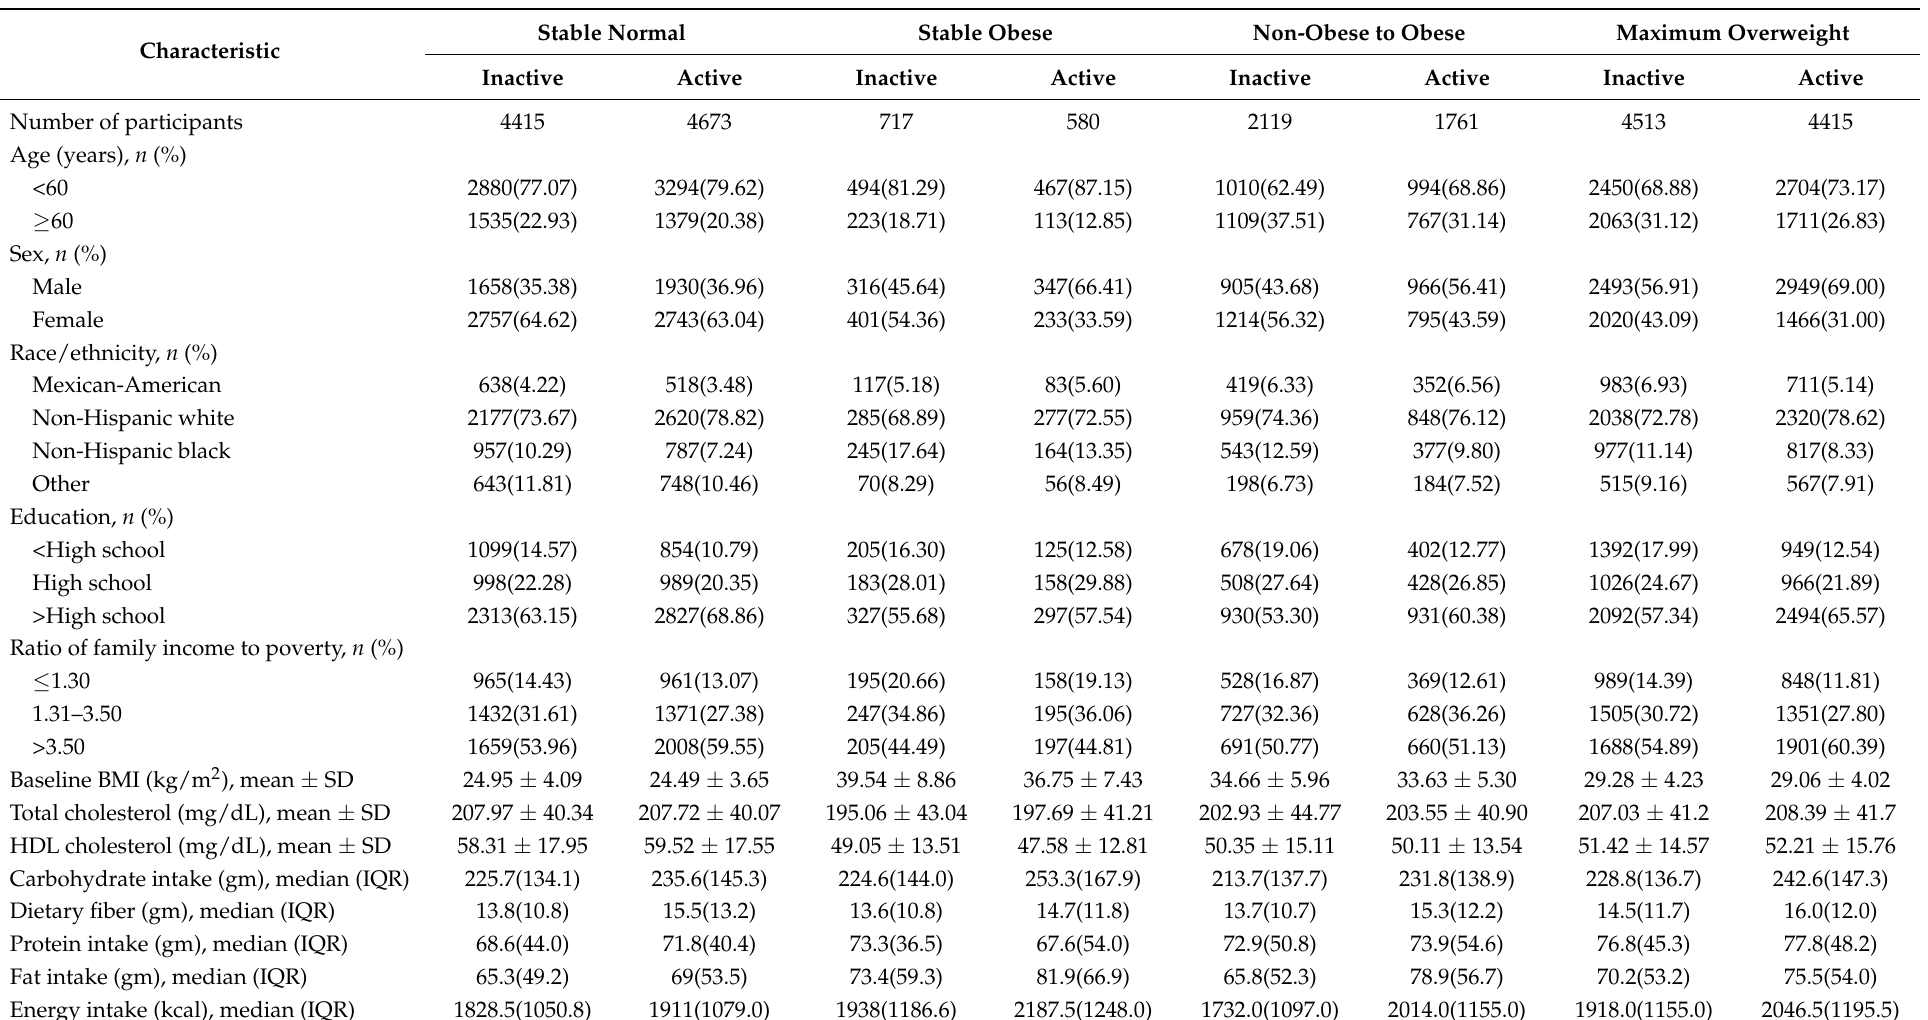
Table 1. Baseline characteristics of the study participants, according to early-adulthood weight change pattern and later physical